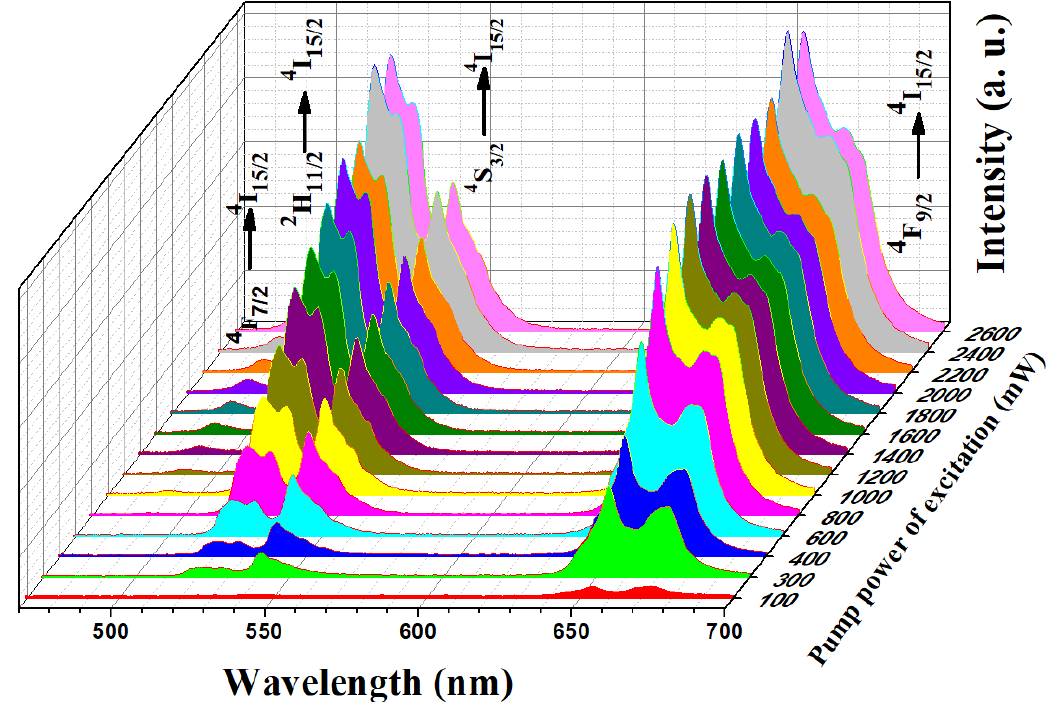
Figure 3. Power-dependent upconversion emission spectra analysis of NaGdF 4 : Er 3+ /Yb 3+ at room temperature excited by a 980 nm diode laser source in the range of 100–2200 mW pump power of excitation.